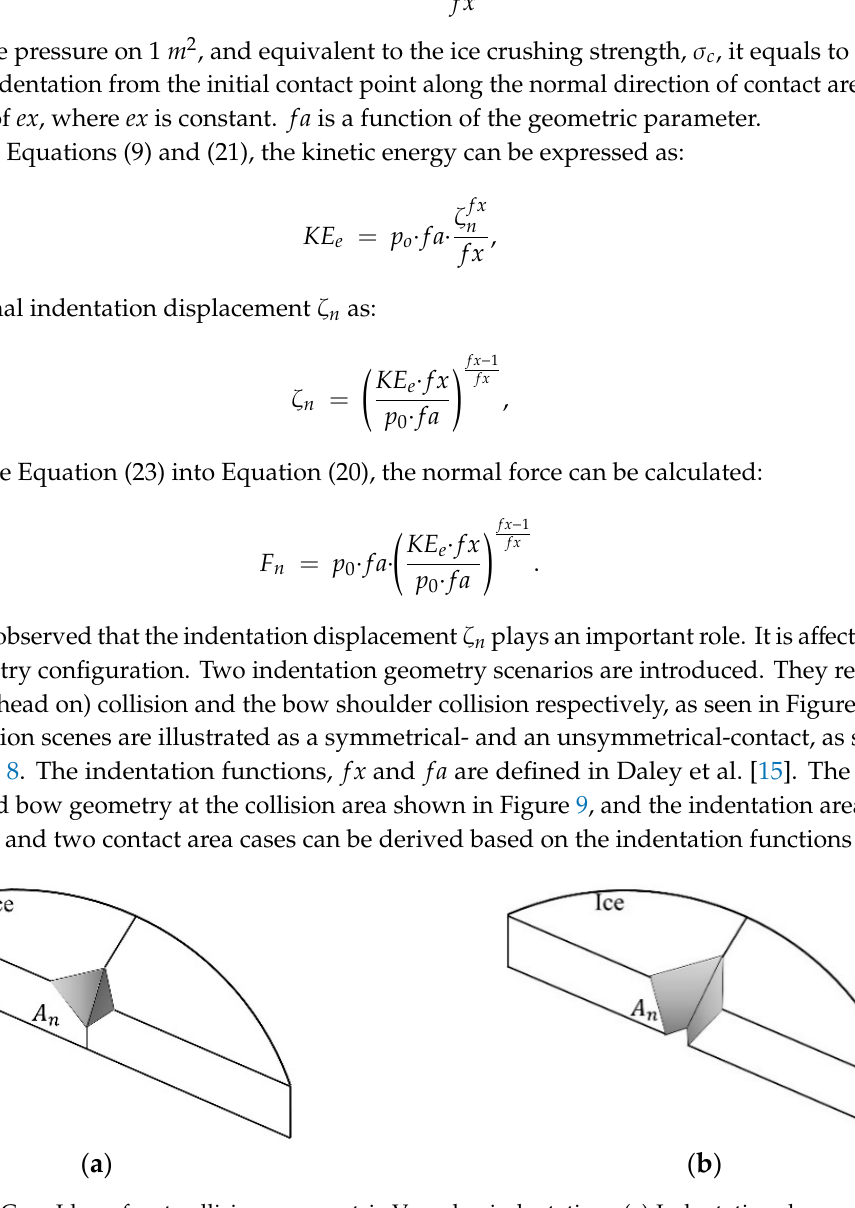
Figure 7. Case I-bow front collision: symmetric V wedge indentation. ( a ) Indentation does not go through the ice thickness; ( b ) Indentation penetrates through the ice thickness.